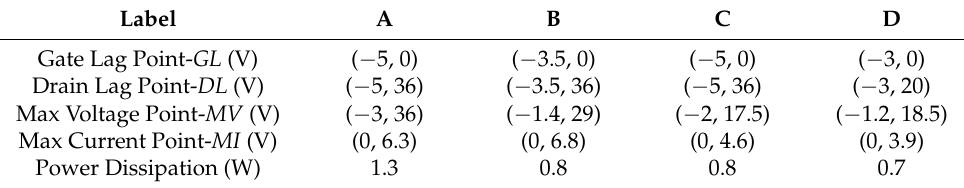
Table 2. Voltage values ( V GQ , V DQ ) and power dissipation points selected for the devices A – D .